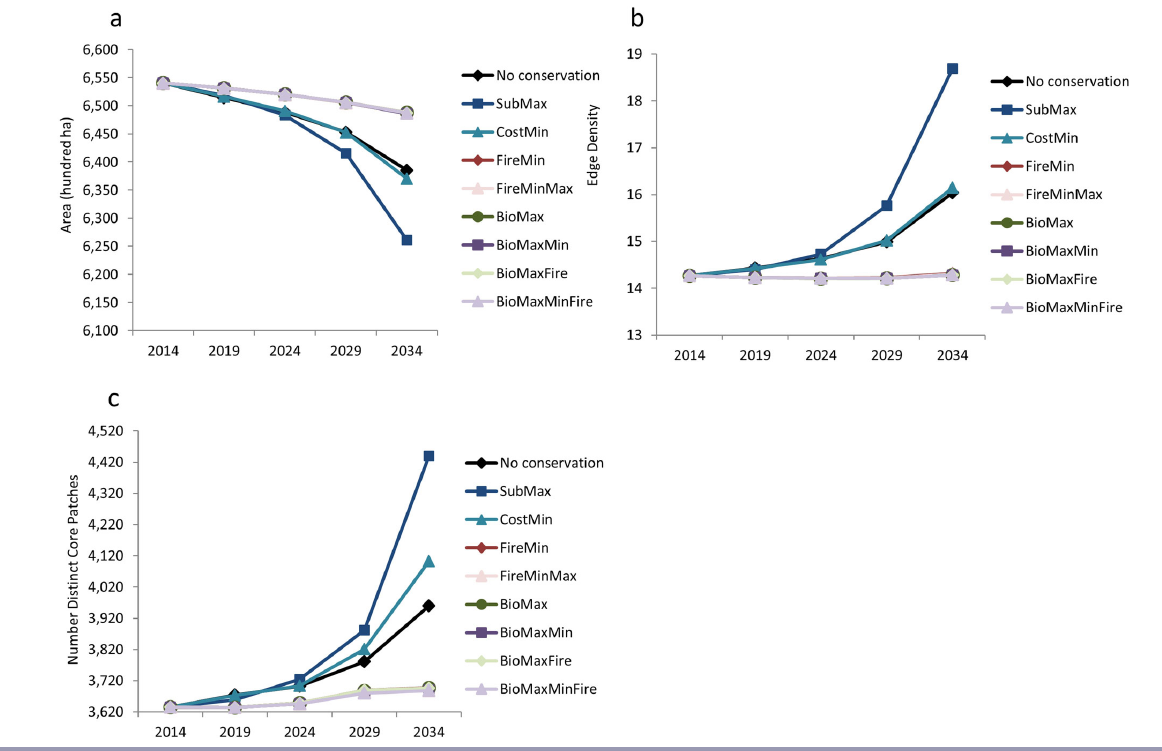
Fig. 5 . Landscape pattern metrics calculated for undeveloped land in all selection scenarios, including (a) area of core habitat, (b) edge density, and (c) number of distinct core